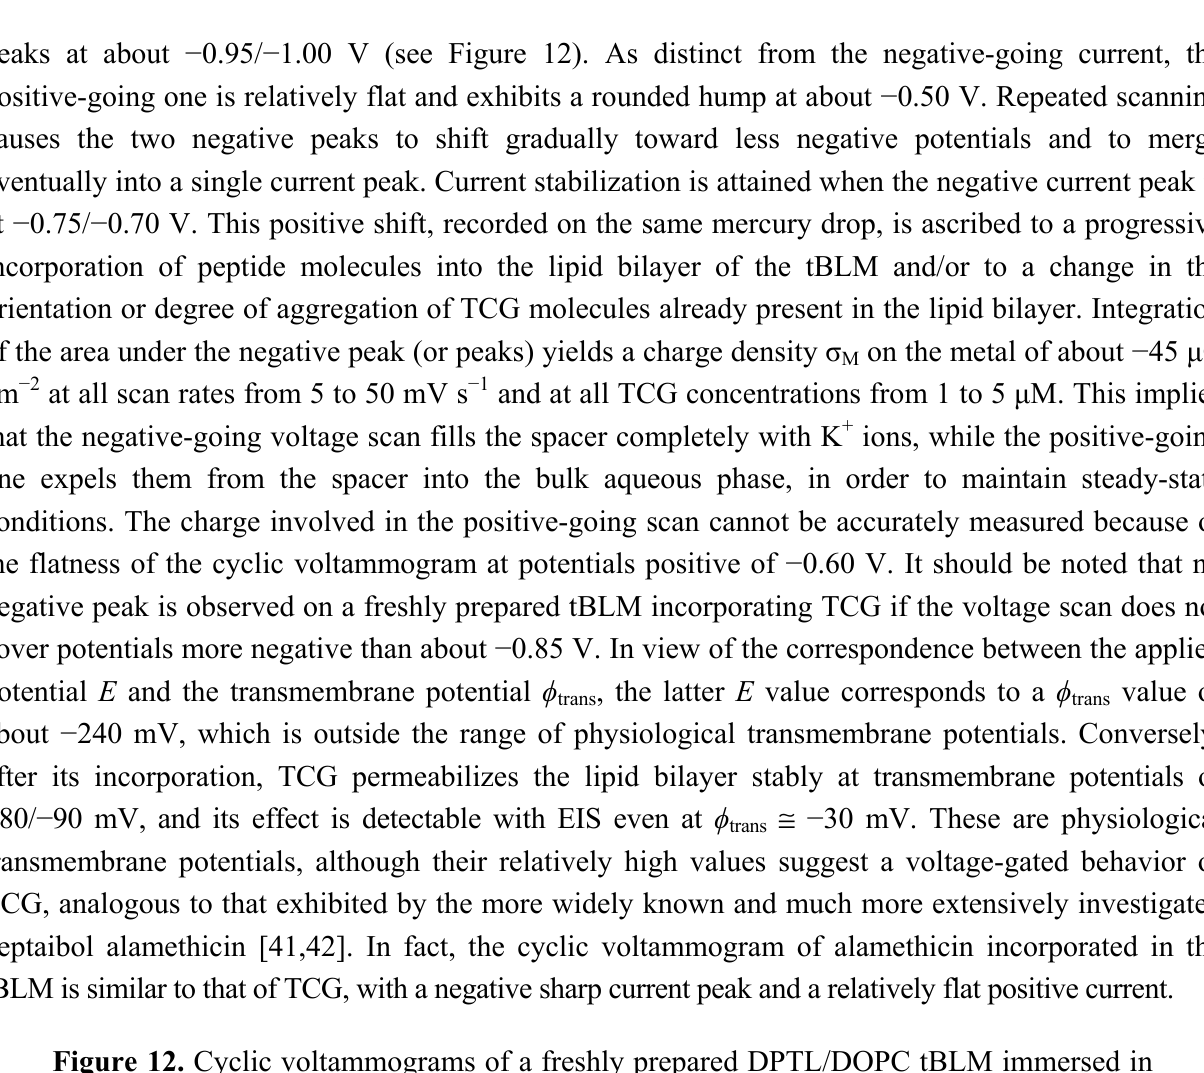
Figure 12. Cyclic voltammograms of a freshly prepared DPTL/DOPC tBLM immersed in aqueous 0.1 M KCl containing 1 μ M TCG. Proceeding from left to right, the cyclic voltammograms were obtained at a scan rate of 10 mV s − 1 after 1, 3, 6, 9, 12 and 15 cycles from the instant of the addition of the